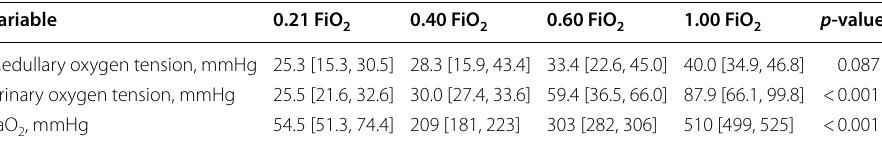
Table 4 Measurements of PaO , medullary oxygen tension and urinary oxygen tension under 2 different FiO settings obtained in the experimental study using healthy adult sheep 2